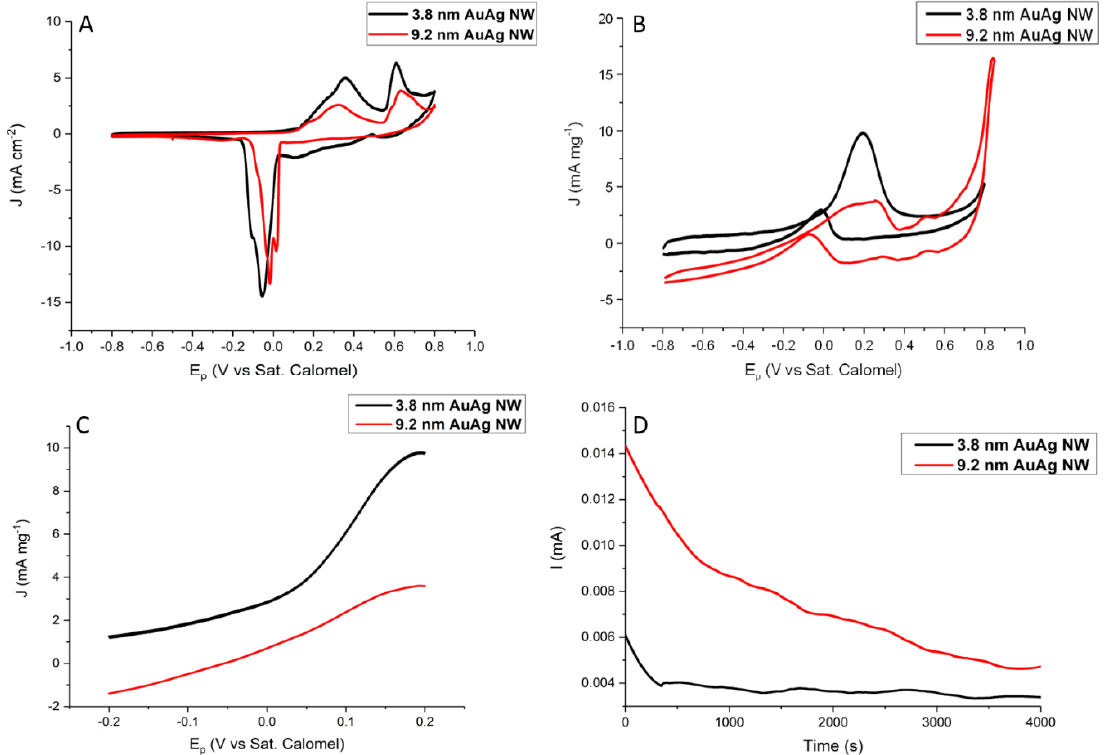
Figure 7. Cyclic voltamogram (CV) curves ( A ) of 3.8 and 9.2 nm AuAg NWs in N 2 -saturated 1M KOH at 50 mV · s − 1 . ( B ) CV curves, ( C ) enlarged CV curves in the forward scan and ( D ) I – T curves over 4000 s for 3.8 and 9.2 nm AuAg NWs in N 2 -saturated 1 M KOH solution containing 0.5 M ethylene glycol (EG) versus the sat. calomel reference electrode. Table 1. Electro-oxidation parameters of EG by various noble metal-based catalysts in an alkaline medium.